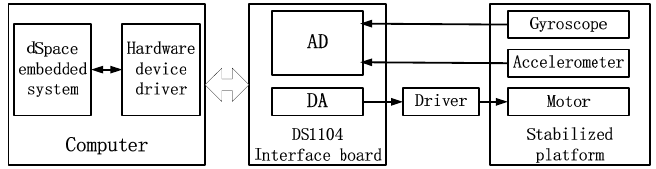
Figure 13. Schematic diagram of the experimental system.